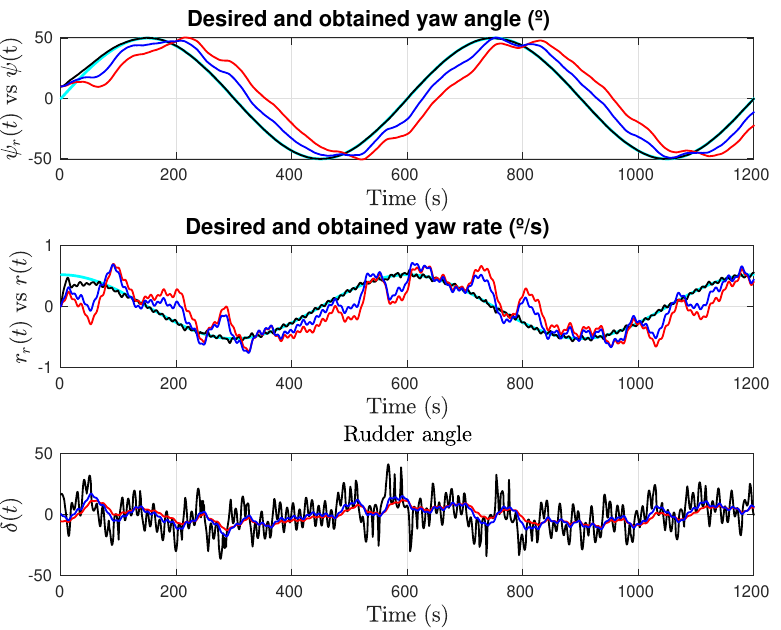
Figure 11. Sinusoidal yaw reference test with d ( t ) (cid:54) = 0. States and control. Cyan line: Reference; Red line: Concise backstepping (Zhang et al.); Blue line: Synergetic (Muhammad et al.); Black line: Adaptive sliding mode (González-Prieto et al.).